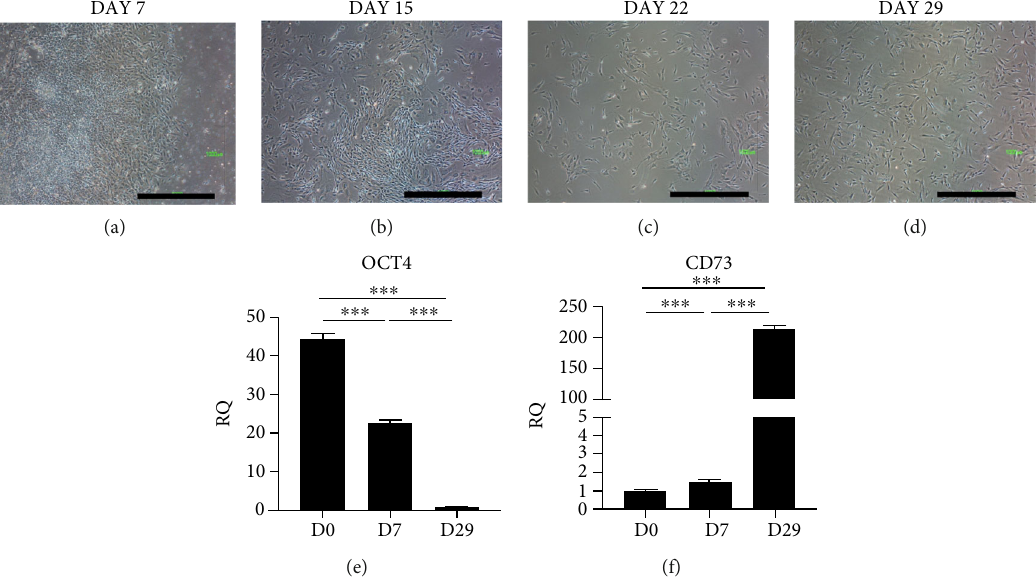
Figure 3: The process from iPSC to mesenchymal stem cell (MSC). (a) The fi broblastic morphology cells (Lt side of the fi gure) appeared on day 7 after di ff erentiation around the epithelial round cell colony (Rt side of the fi gure). (b) At day 14, more fi broblast-like cells appeared. (c) At day 21, around 100% of cells were fi broblastic appearance cells. (d) On day 29, fully di ff erentiated MSC were noted. Scale bar = 1000 μ m . (e) qPCR showed a decreasing trend of pluripotency gene ( OCT4 ) expression from postdi ff erentiation day 7 to day 29. (f) qPCR showed an increasing trend of MSC gene ( CD73 ) expression from postdi ff erentiation day 7 to day 29. ∗∗∗ p < 0 : 001 . We used an ANOVA test with a post hoc analysis with the Bonferroni test.